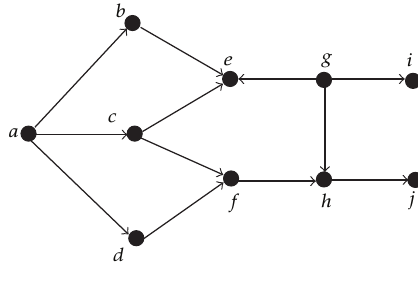
Figure 1: A directed graph (cid:2)G V